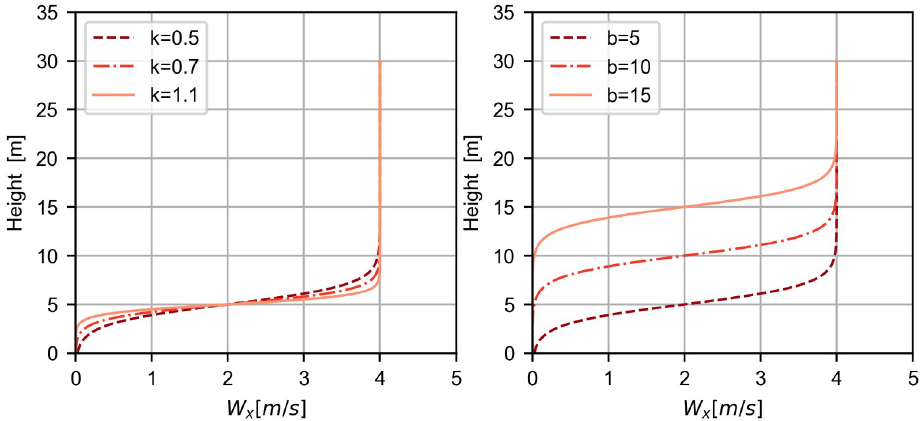
Fig 3. Step wind profiles. Effect of changing parameters k and b in the shape of the step wind profile (here A = 4).